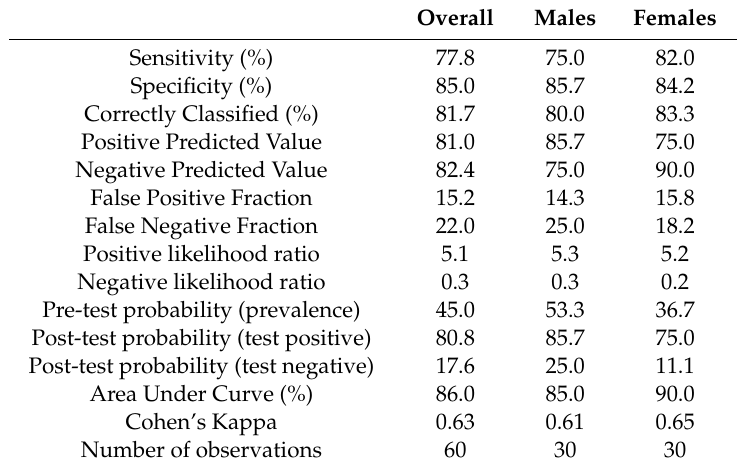
Table 2. Summary indices of the ultrasound performance for detection of non-alcoholic fatty liver disease (NAFLD) at a cut-o ff point ≥